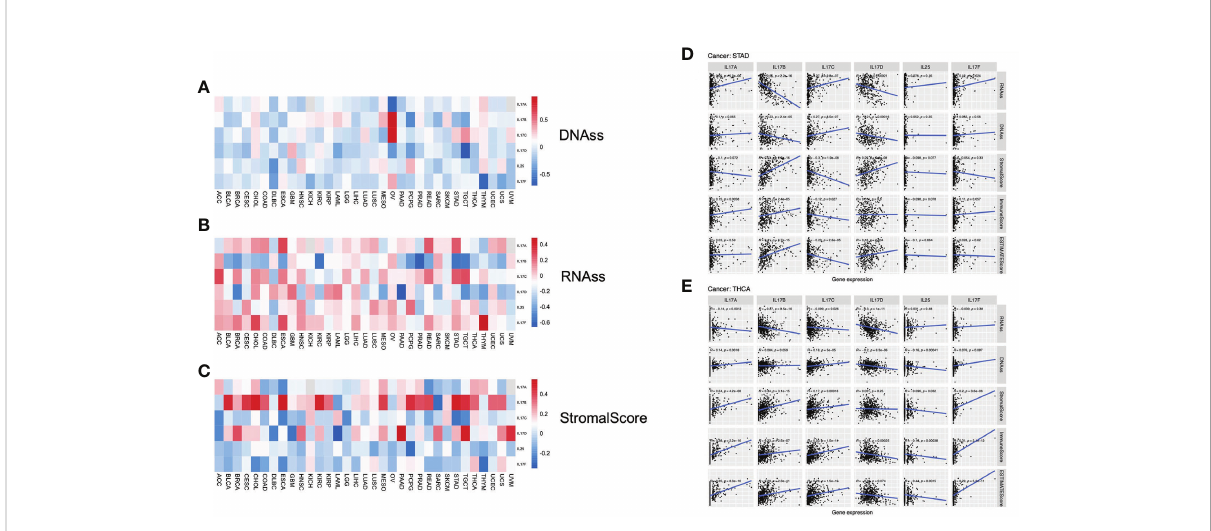
FIGURE 4 (A – C) Correlation analysis between IL-17A – F expression and stemness indices and tumor microenvironment (TME). The association between IL-17A – F expression and DNAss, RNAss, and stromal score in 33 TCGA cancer types. (Red points indicate positive correlation, while blue points indicate negative correlation.) (D, E) The association between IL-17A – F expression and stemness indices (RNAss and DNAss), stromal scores, immune scores, and ESTIMATE scores in STAD and THCA in TCGA